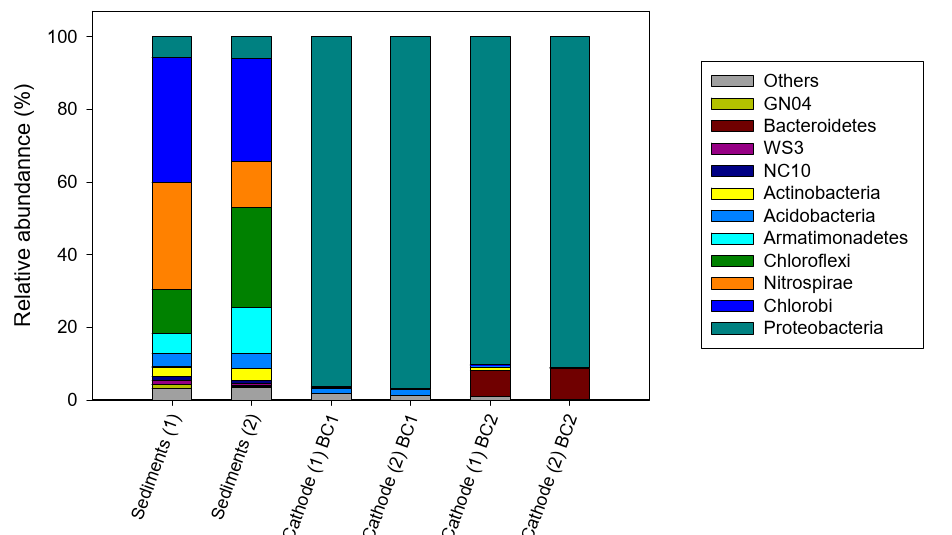
Figure 4. Relative abundances of bacteria phyla in sediments and cathodes from columns BC1 and BC2 (21 cm of cathode–anode distance, green line in Figure 3). The number in parentheses represents the replicate. The bacterial group others consisted of sequences of other phyla comprising less than 0.1% of classified sequences.